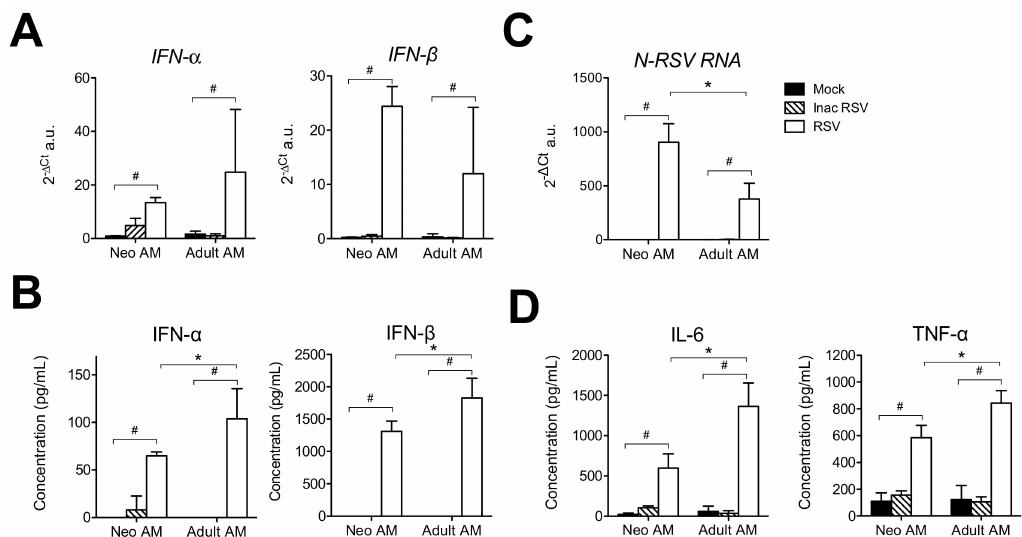
Figure 4. Neonatal primary AMs produced IFN-I and inflammatory cytokines in response to in vitro RSV infection. Primary AMs of 6 day-old (pool of n = 50) or adult (pool of n = 5) BALB / c mice were exposed for 24 h to RSV-mCherry, UV inactivated-RSV-mCherry (Inac RSV, 5 × 10 4 cells / well, MOI = 5), or Mock control. Type-I IFN responses were evaluated ( A ) by qRT-PCR on cell lysates and ( B ) by luminex assays in cellular supernatants. ( C ) Infection was analyzed by measurement of viral N-RSV RNA expression by qRT-PCR from cell lysates. ( D ) Inflammatory cytokine production in supernatants was evaluated by luminex assays. Results are expressed as mean of triplicate ± SEM (one representative experiment of three). # indicated the statistical significance of di ff erences between control conditions and RSV condition and was determined by the Mann–Whitney test (# p < 0.05). The statistical significance of di ff erences between neonatal and adult primary AMs was indicated by * symbol and was determined by the Mann–Whitney test (* p <